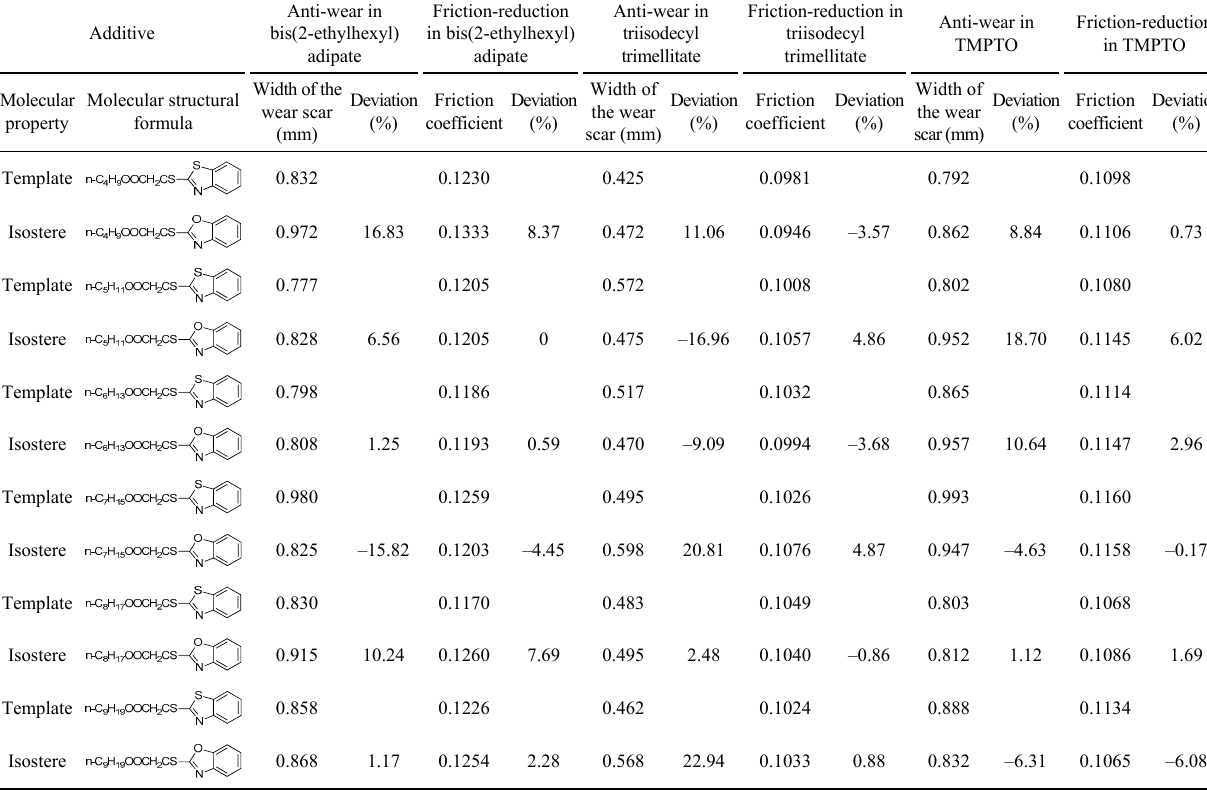
Table 2 The tribological test results of the corresponding lubricant with 2-benzothiazole-S-carboxylic acid esters or isosteres. Anti-wear in Additive